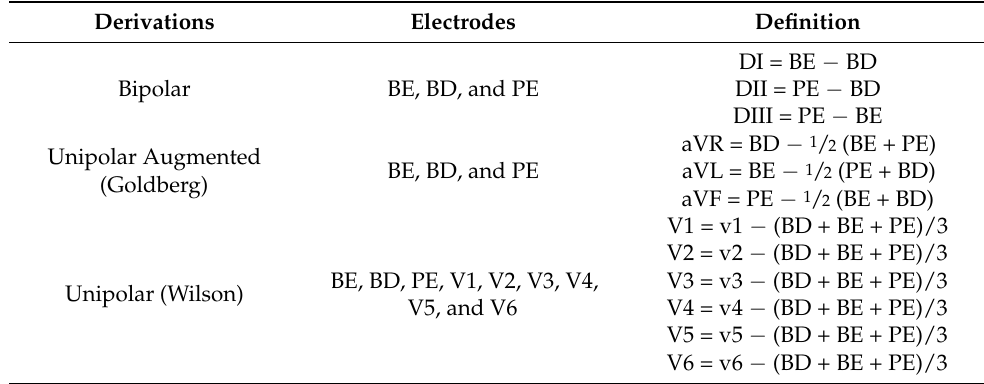
Table 1. Electrodes and their derivations—mathematical